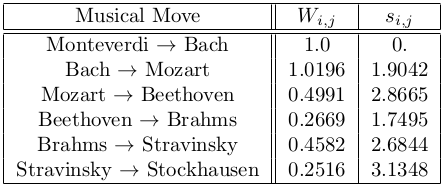
Table from the paper: Can the evolution of music be analyzed in a quantitative manner?
Table text:
MusicalMove
W i,j
s i,j
Monteverdi → Bach
1.0
0.
Bach → Mozart
1.0196
1.9042
Mozart → Beethoven
0.4991
2.8665
Beethoven → Brahms
0.2669
1.7495
Brahms → Stravinsky
0.4582
2.6844
Stravinsky → Stockhausen
0.2516
3.1348